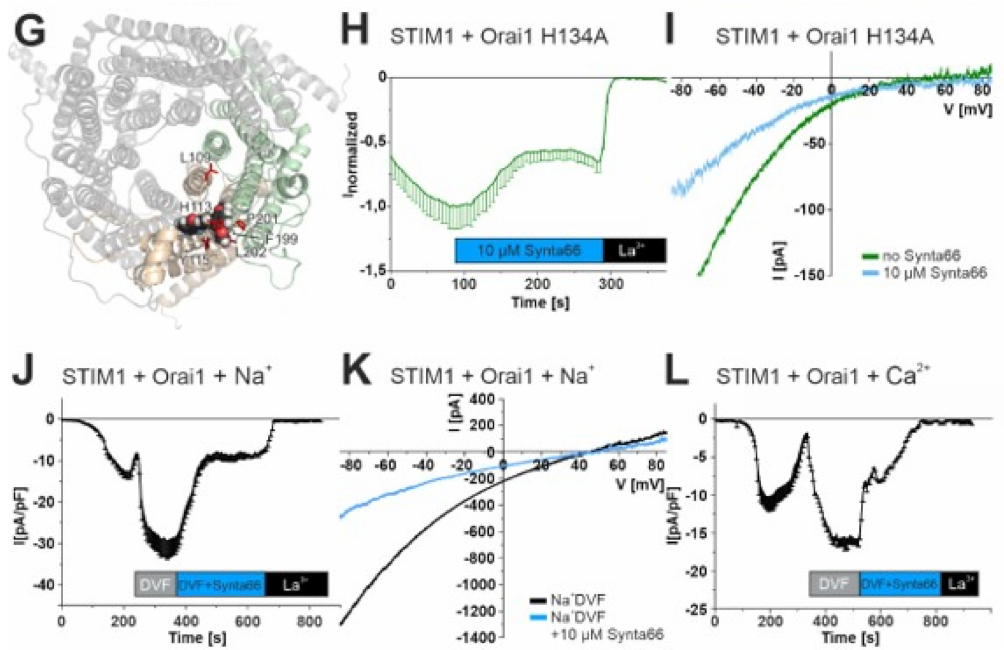
Figure 3. Synta66 inhibition is impaired in Orai1 mutants that yield non-selective permeation: ( A ) Snapshot of Orai1 channel (top view) with a single Synta66 bound to loop1 and loop3 residues of Orai1. Residues that are mutated in ( B–E ) are highlighted as red sticks. ( B , D , H ) Time course of store-operated whole-cell currents at − 86 mV for a co-expression of STIM1 and ( B ) Orai1 loop1 mutant (L109D, H113G, Y115G), ( D ) Orai1 loop3 mutant (F199G, P201G, L202G) or ( H ) Orai H134A mutant. Upon maximum Orai1 activation, 10 µ M Synta66 was added to the extracellular solution followed by 10 µ M La 3 + . ( C , E , I ) Current voltage relationships from representative experiments from ( B , D , H ) upon maximal store-operated Ca 2 + activation and of steady state currents upon perfusion with a 10 µ M Synta66 containing solution. ( F ) Side view of the wild-type Orai1 channel (left) and Orai1-H134A mutant (right) with residues from ( A ) and H134 / A134 highlighted as stick model. ( G ) Structure of the Orai1-H134A simulations (top view) with residues from ( A ) highlighted. ( J , L ) Time course of store-operated whole-cell currents at − 86 mV by STIM1 and Orai1 in a standard Ca 2 + based extracellular solution. After reaching a maximum current plateau, extracellular solution was substituted to a Na + based divalent ion free solution (Na + DVF). Currents were subsequently monitored in a ( J ) Na + DVF with 10 µ M Synta66 or ( L ) Ca 2 + based extracellular solution with 10 µ M Synta66. ( K ) Current voltage relationships from representative experiments from (I) in a Na-DVF solution (black) or with 10 µ M Synta66